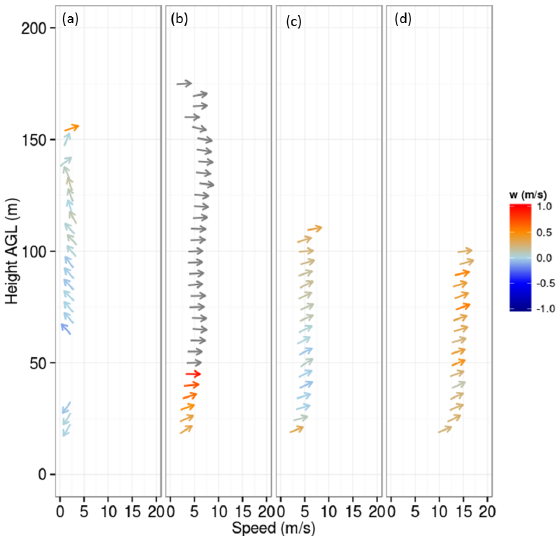
Figure 6. Vertical profiles measured at GRI duirng (a) downslope (14 July 2010, 00:00 LT), (b) upslope (15 July 2010, 11:00 LT), (c) afternoon (15 July 2010, 16:00 LT), and (d) synoptically forced (17 July 2010, 15:00 LT) flow